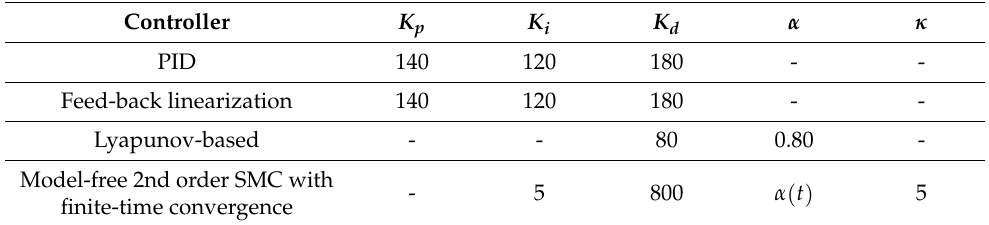
Table 3. Gain matrices for classic controllers and the proposed model-free 2nd order SMC with finite-time convergence.